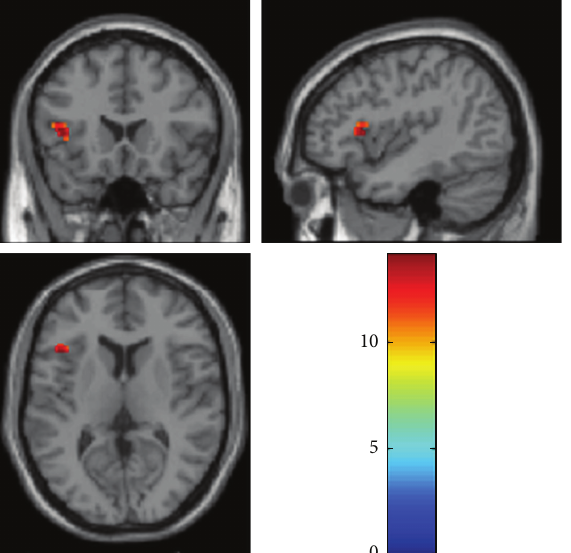
Figure 3: Activation map for main effect of time in the separate analysis of the POST HL group with ROI based on bilateral IFG showing activation of left IFG (Broca’s area BA 45).